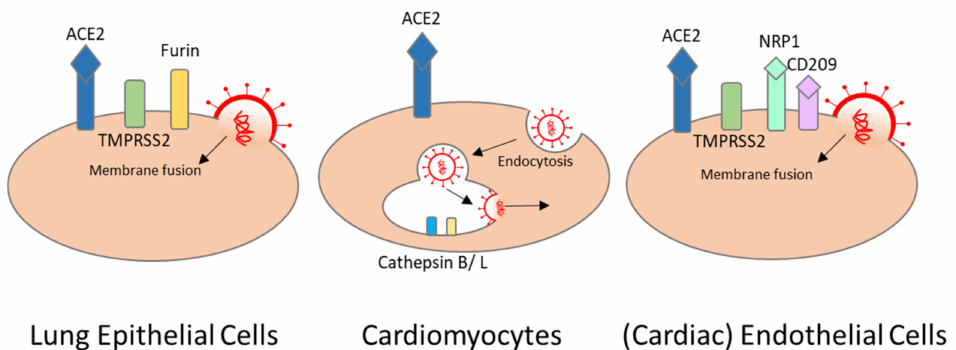
Figure 2. SARS-CoV-2 entry into cells of the heart. severe acute respiratory syndrome coronavirus 2 (SARS-CoV-2) can use angiotensin-converting-enzyme 2 (ACE2) as a receptor and different proteases to prime the spike protein. Depending on which protease is used for spike S protein priming, a different path is used for viral entry; i.e., membrane fusion or endocytosis. ACE2, angiotensin- converting-enzyme 2; TMPRSS2, transmembrane protease serine 2; NRP1,